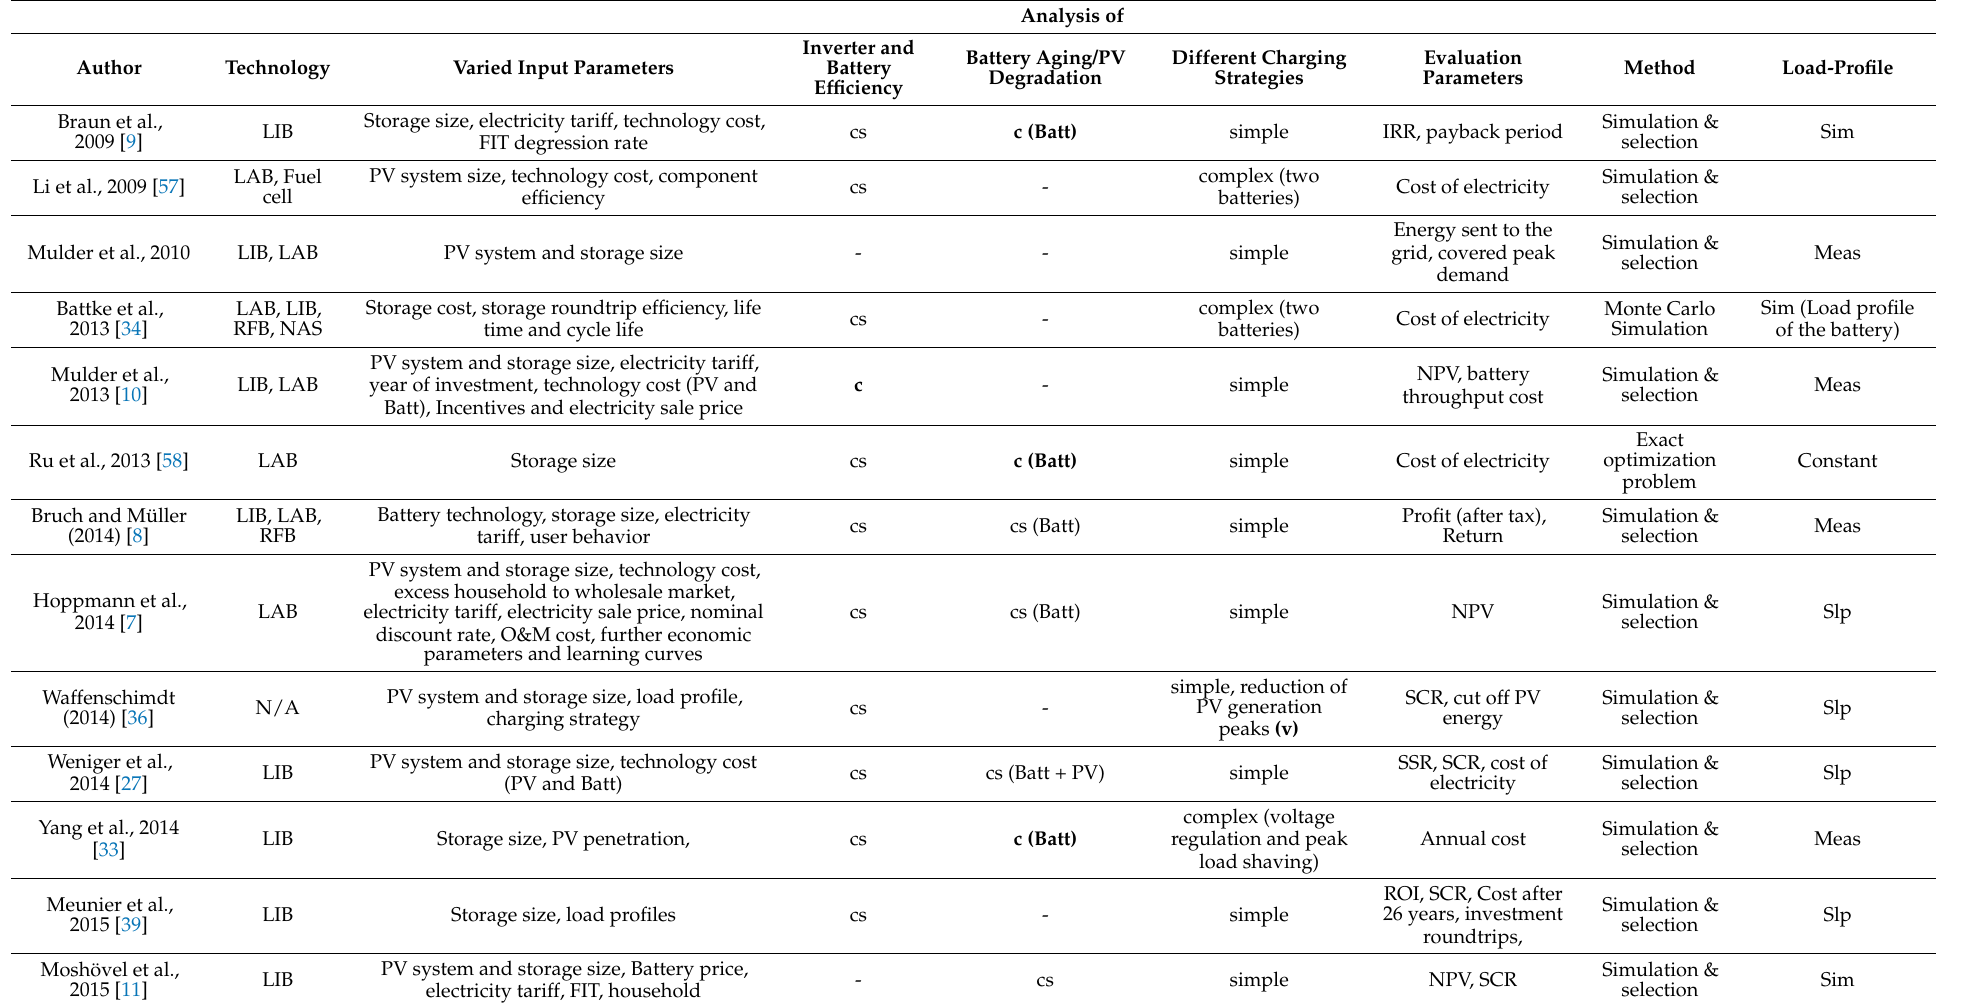
Table 1. Literature review on the simulation and sizing of PV home storage systems with a special focus on the consideration of efficiencies, aging and charging